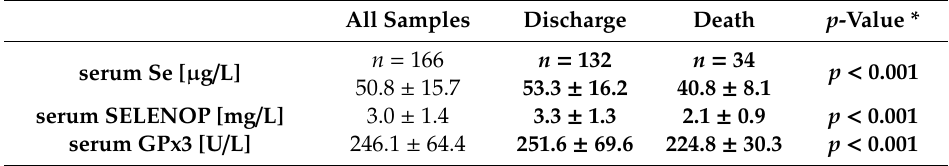
Table 2. Comparison of Se status biomarkers in COVID-19 samples in relation to survival. All